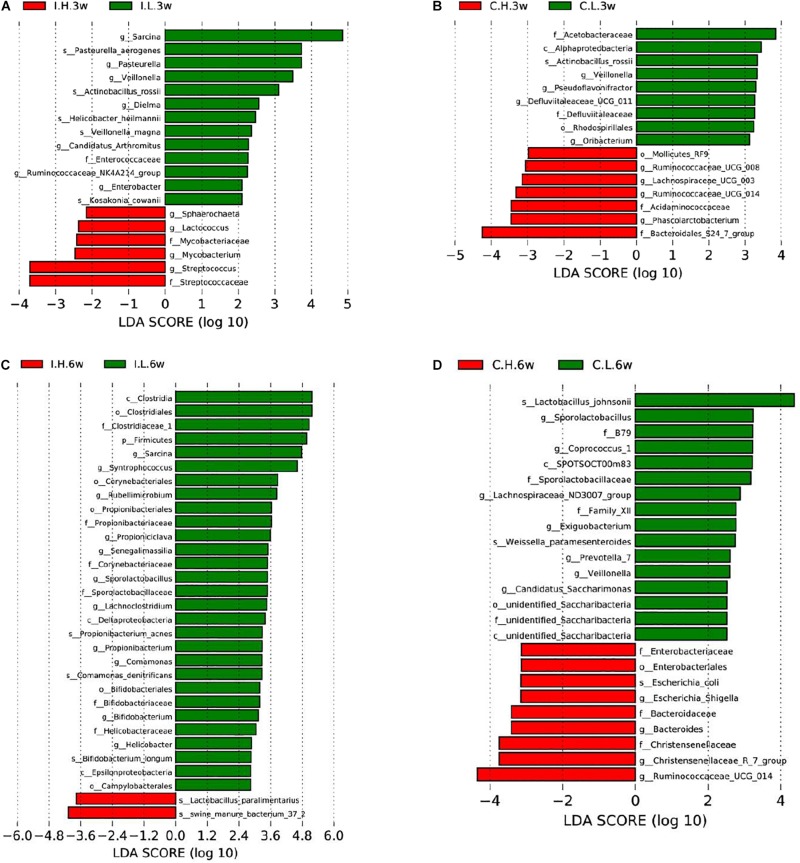
Significantly different compositions of the ileal and cecal microbiota between control and Cu-supplemented groups determined by linear discriminant analysis (LDA) effect size analysis after 3 and 6 weeks of feeding in weaned piglets. Significantly different compositions of the ileal (A) and cecal (B) microbiota after 3 weeks of feeding and significantly different compositions of the ileal (C) and cecal (D) microbiota after 6 weeks of feeding. I, ileal microbiota; C, cecal microbiota; L, control group; H, Cu-supplemented group; 3w, 3 weeks of feeding after weaning; 6w, 6 weeks of feeding after weaning.